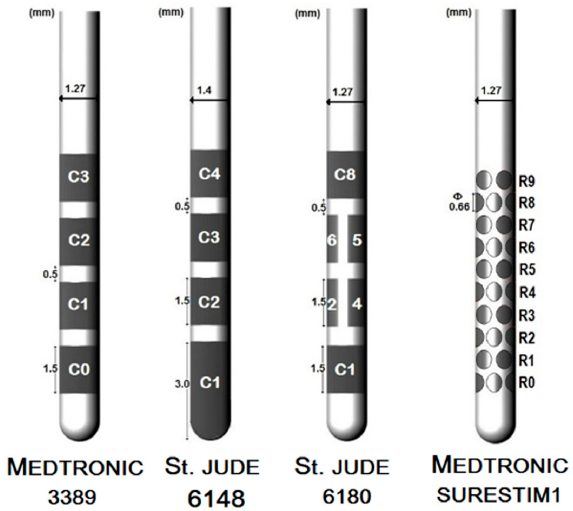
Figure 1. Representation of the conventional and the steering field leads.